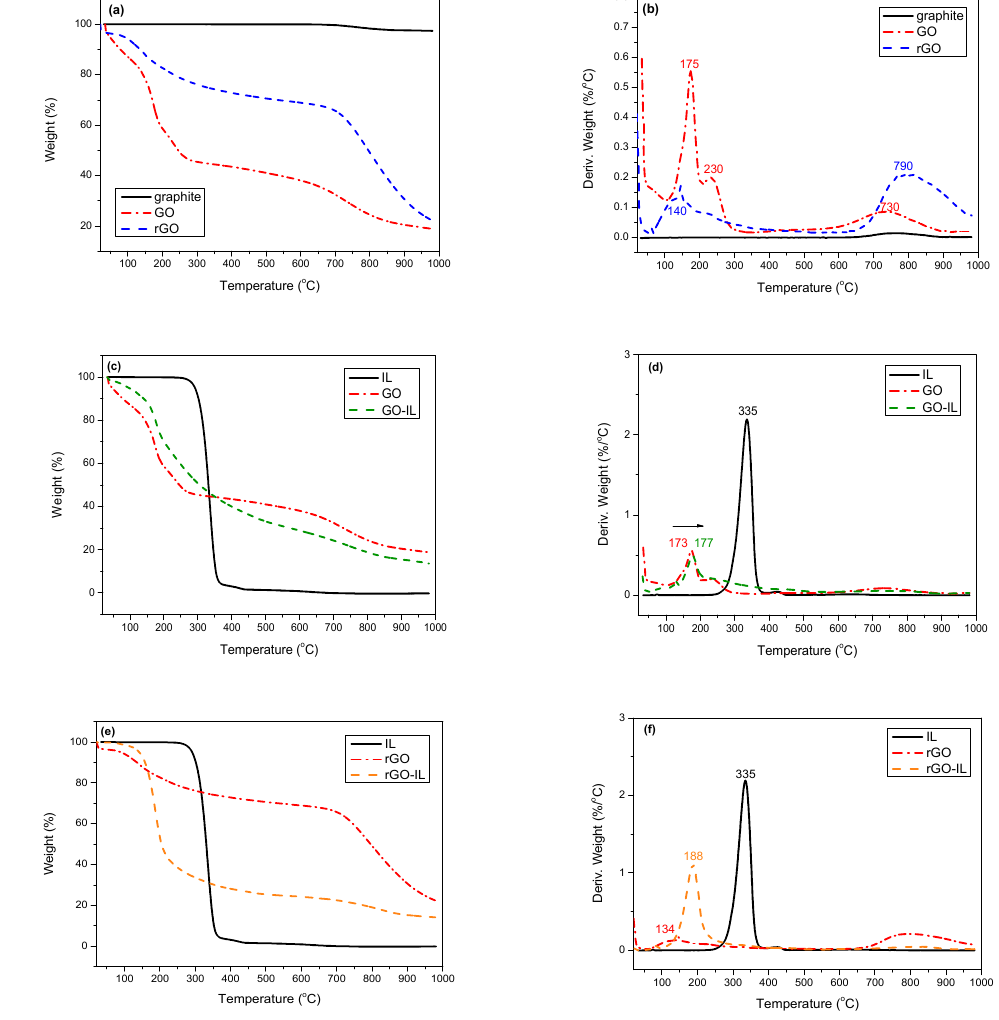
Figure 1. Thermogravimetric Analysis (TGA) ( a ) and derivative thermogravimetry (DTG) ( b ) thermograms of graphite, graphene oxide (GO), and reductive graphene oxide (rGO); TGA ( c ) and DTG ( d ) curves of GO, IL, GO-IL; TGA ( e ) and DTG ( f ) curves of rGO, IL, rGO-IL under N 2 atmosphere.